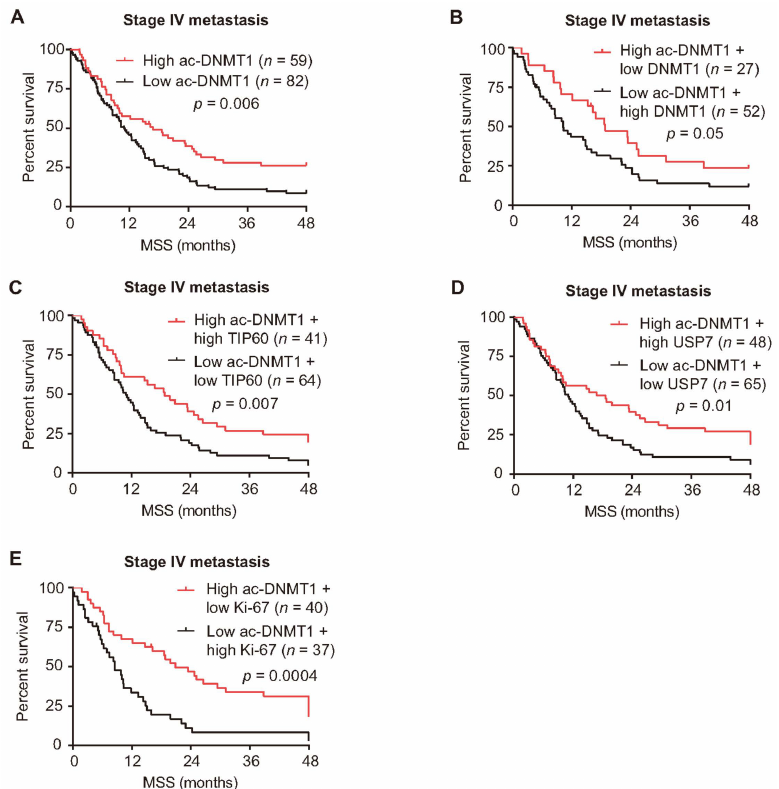
Figure 7. Low ac-DNMT1 protein level is a predictive factor for poor MSS. ( A ) MSS curves for stage IV metastasis from the TMA cohort. Patients were divided according to the mean IHC H-scores of ac-DNMT1. ( B ) MSS curves for stage IV metastasis from the TMA cohort. Patients were divided according to the mean IHC H-scores of ac-DNMT1 together with DNMT1 ( B ), TIP60 ( C ), USP7 ( D ), and Ki-67 ( E ) into high and low groups, respectively.